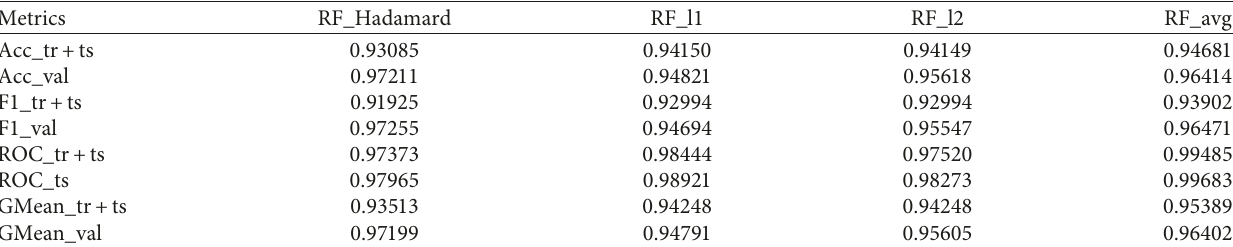
Table 5: For replying interaction from March 12 until April 12 in 2021, utilizing the obtained embeddings through Node2Vec, performance of the RF model with operators Hadamard, l1, l2, and average 1,2 .